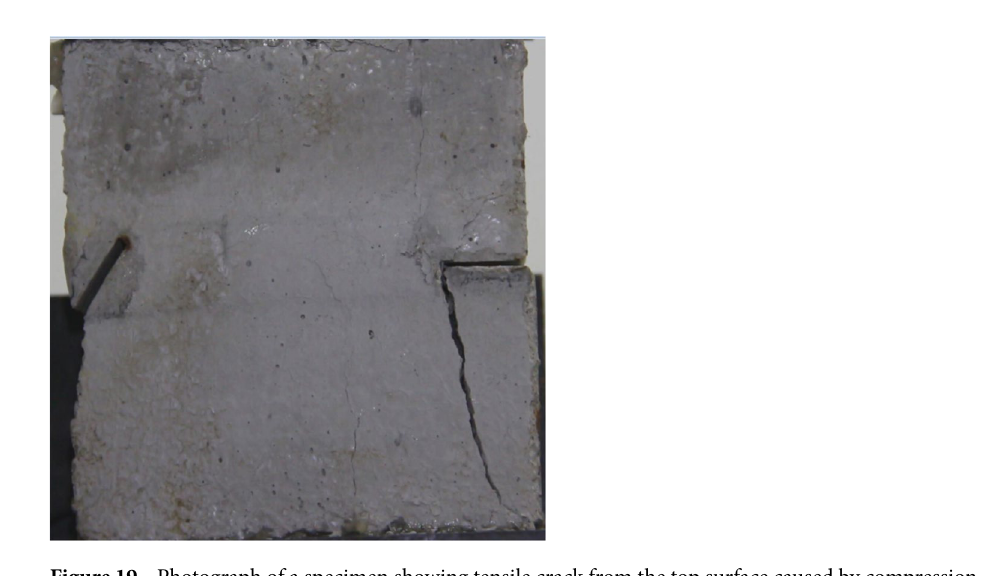
extended upward were produced, followed by anti-tensile cracks that extended downward. These cracks were initiated at different points and propagated in different directions.